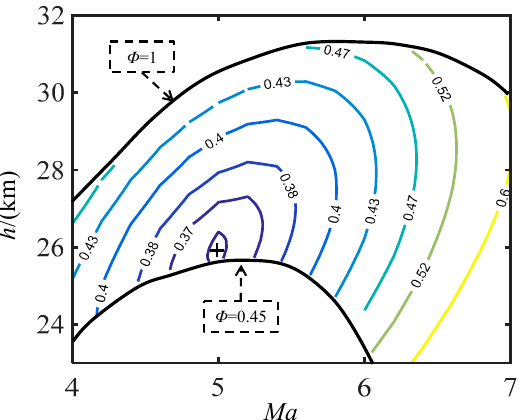
Figure 15. Optimal point and contour of fuel consumption after adjustment.